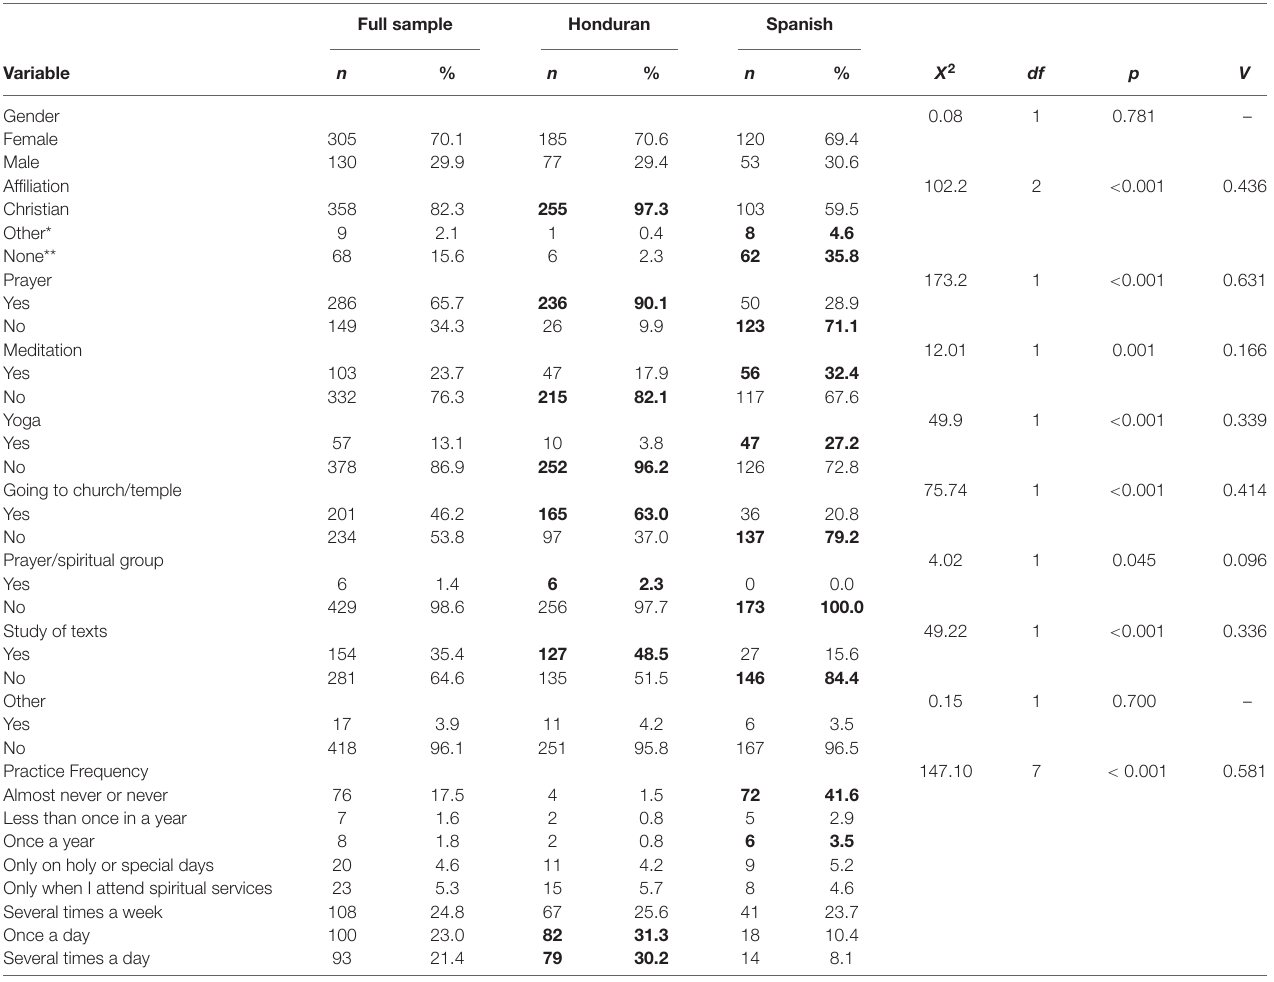
TABLE 3 | Characteristics of participants, full sample by nationality. gender, affiliation, and R/S practices. Full sample